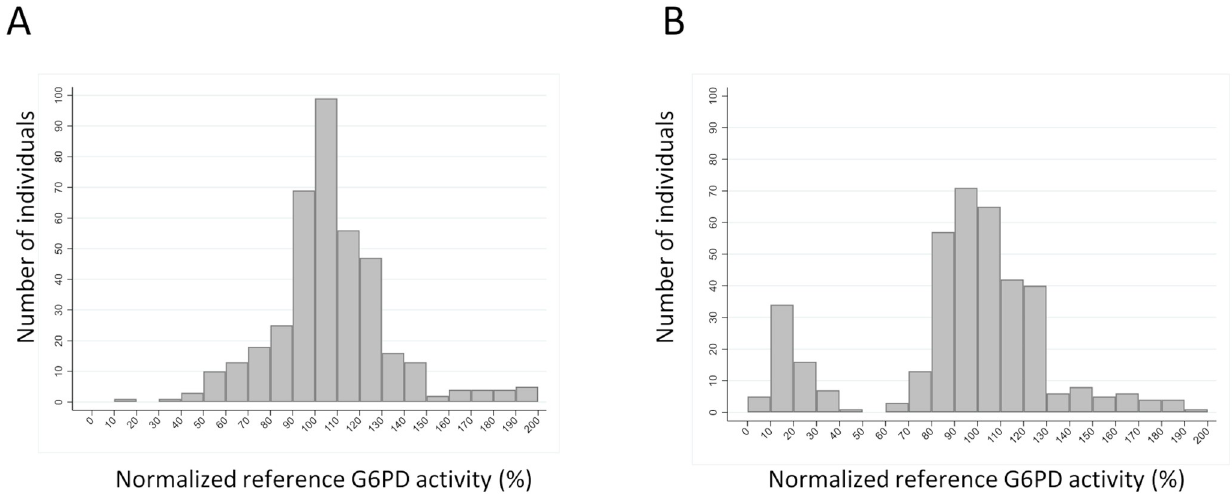
Fig 4. Histogram representation of the G6PD activity distributions in (A) females and (B) males. The reference G6PD values (U/g Hb) were normalized using the male medians and are presented here in percent activity.